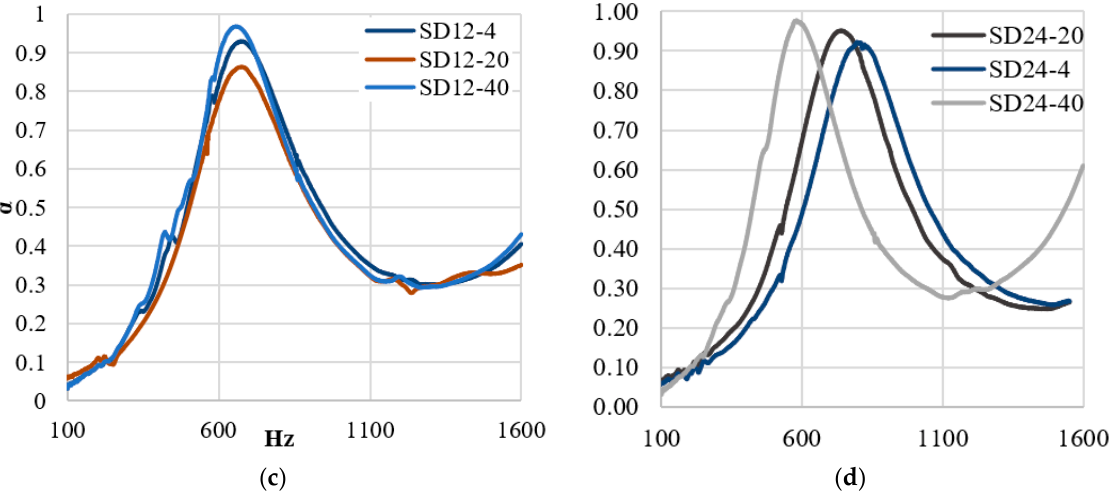
Figure 4. Sound absorption coefficient of gypsum EPS composites with different gypsum content: ( a ) CM series, ( b ) SD3 and SD6 series, ( c ) SD12 series, and ( d ) SD24 series.